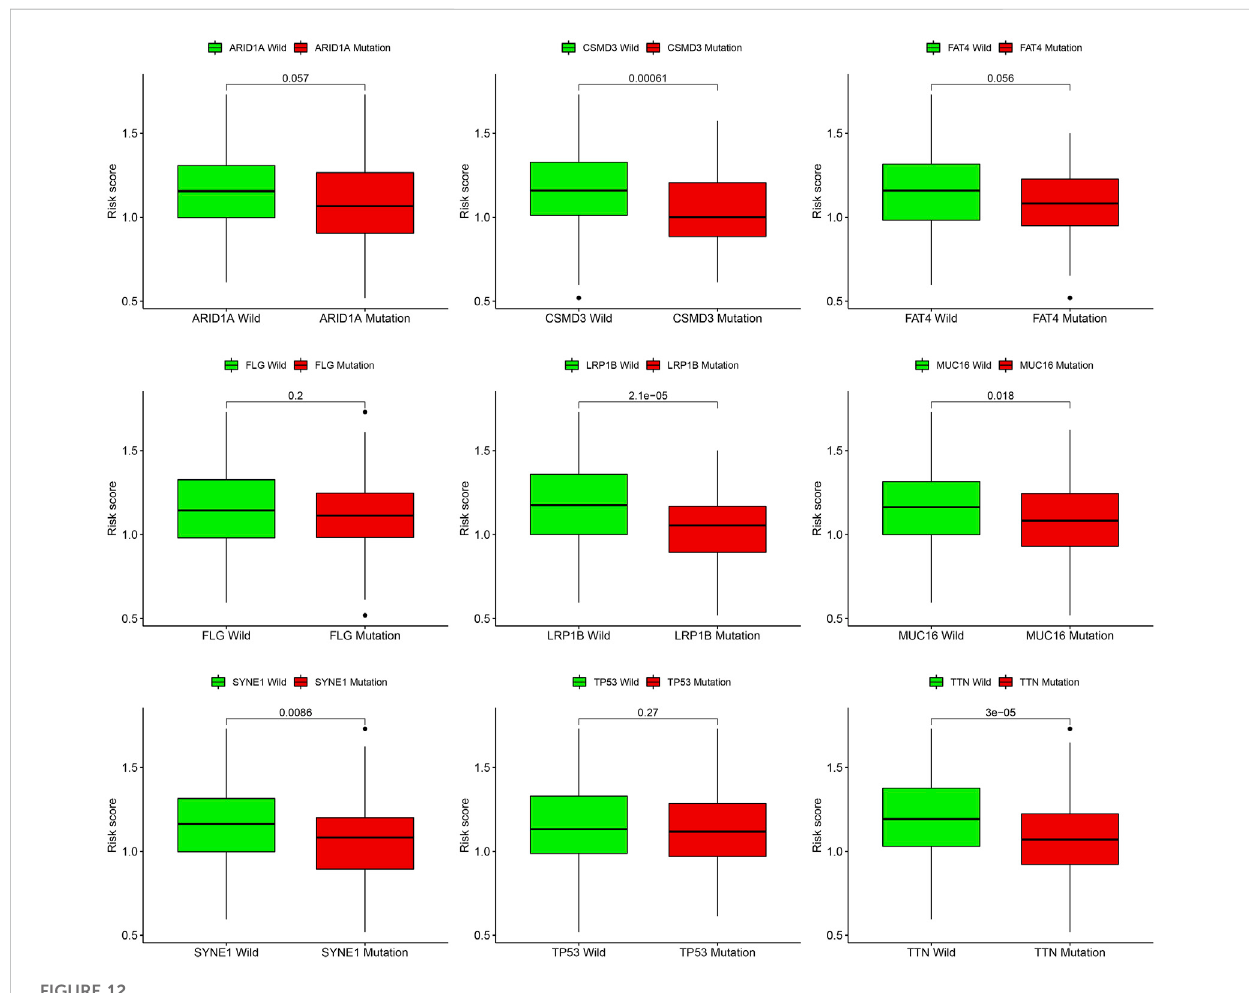
FIGURE 12 Risk score difference of distinct gene mutation